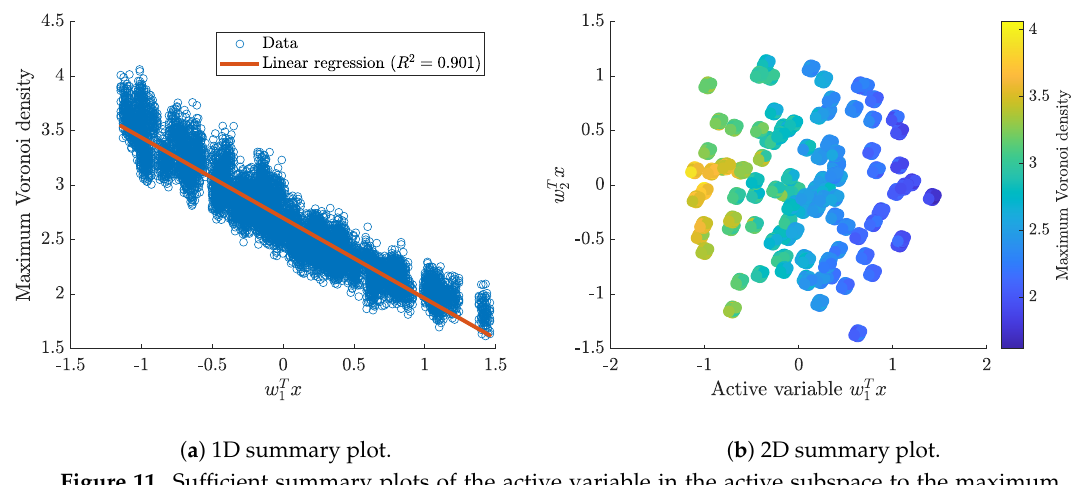
Figure 11. Sufficient summary plots of the active variable in the active subspace to the maximum Voronoi density (quantity of interest) using the gradient samples for 81 samples ( α = 20).